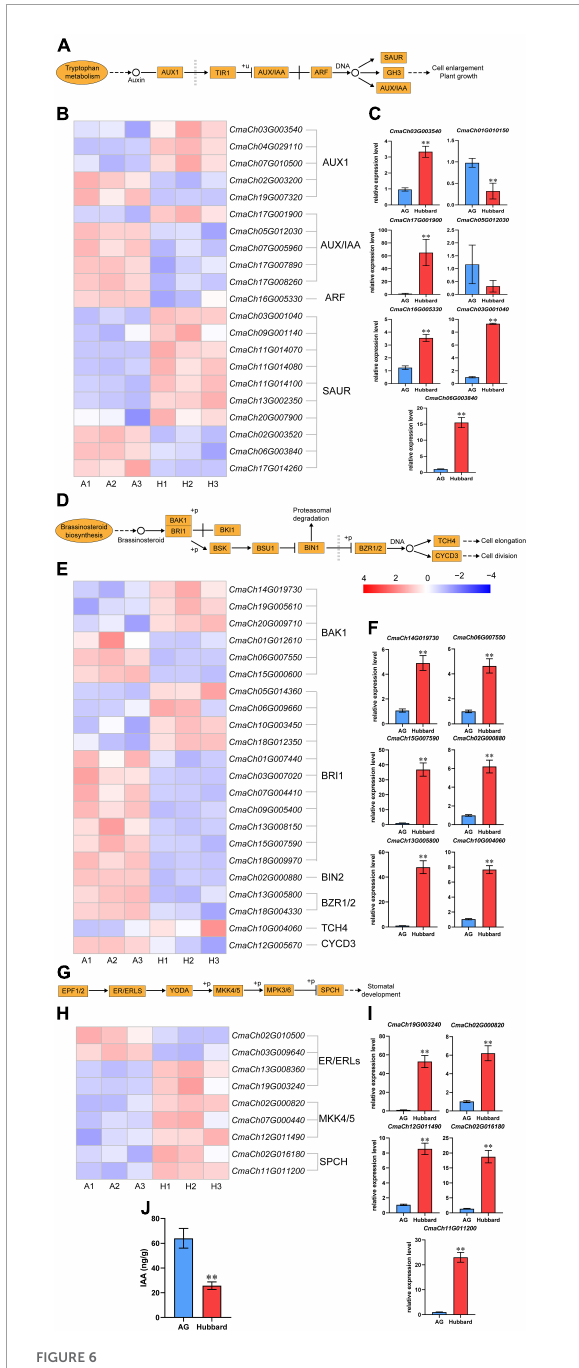
FIGURE6 Visualization and validation of transcript expression in three pathways. The pathways were related to indole-3-acetic acid (IAA) (A) , brassinosteroid (BR) (D) in plant hormone signal transduction and ERECTA (ER) (G) in MAPK signaling pathway-plant. (B,E,H) The heatmap was plotted using Fragments Per Kilobase Million (FPKM) from RNA-seq data. (C,F,I) The expression levels of some differentially expressed genes (DEGs) involved in three pathway map between Atlantic Giant (AG) and Hubbard samples by qRT-PCR. (J) The level of IAA in AG and Hubbard. Date are presented as means ± SD ( n = 3, one-way ANOVA, * P < 0.05, ** P <